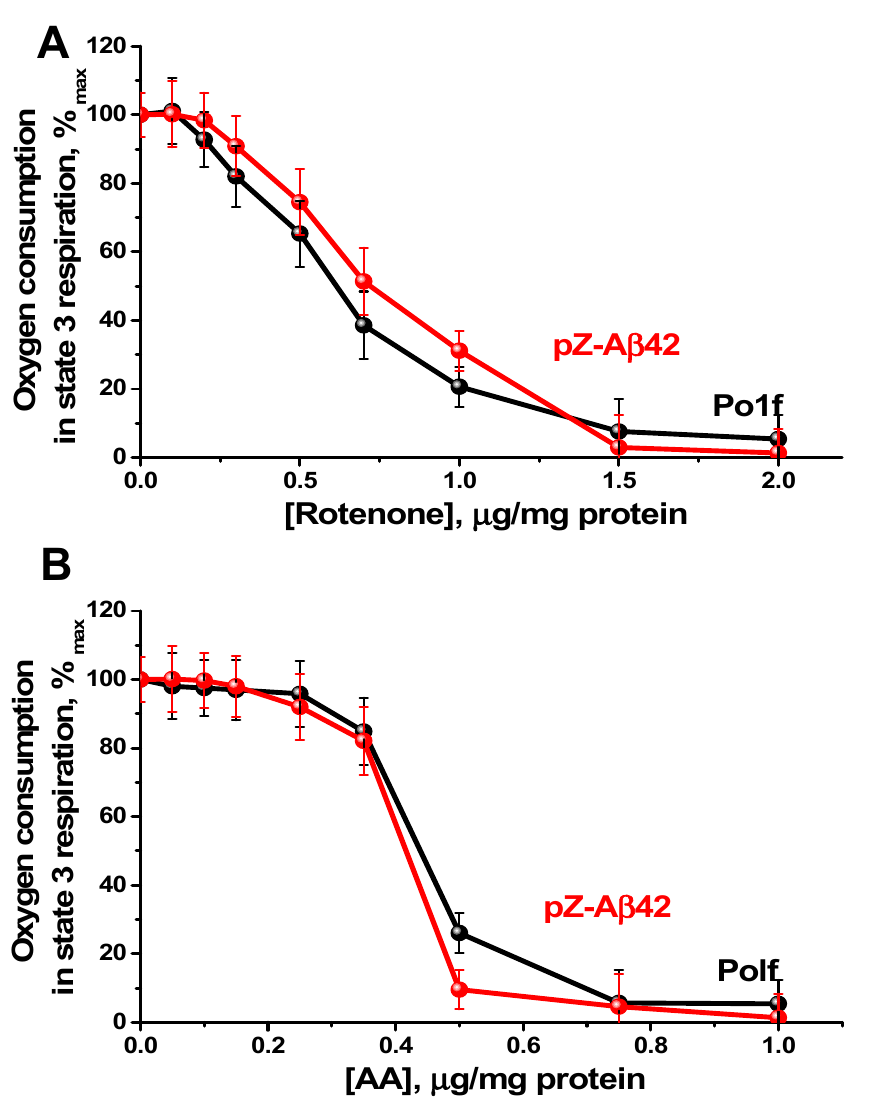
Figure 6. Inhibition of oxygen consumption by Y. lipolytica mitochondria in state 3 respiration by respiratory inhibitors: rotenone ( A ) and antimycin ( B ). Incubation medium was supplemented with 20 mM Tris-pyruvate + 5 mM Tris-malate, 1 mM ADP, and mitochondria (0.5 mg protein/mL). Thus, the comprehensive comparative study of energy parameters of mitochondria The ATP production by the mitochondria of cells expressing A β 42 was on average isolated from the control strain and A β 42-expressing cells showed that A β 42 expression 25% lower than in the control strain (Figure 7). Oligomycin, the specific inhibitor of ATP induced mitochondrial dysfunction, as evident from the partial uncoupling of respiration synthase, was used as a negative control. The differences between the two strains were and phosphorylation, the reduced ATP production rate, and the increased susceptibility to small, but reliable. In mitochondria from the control strain, oligomycin almost completely oxidative inhibited ATP synthesis, while in mitochondria from the A β 42 expressing cells, the degree of inhibition was reliably lower, again indicating that these mitochondria were partially uncoupled.